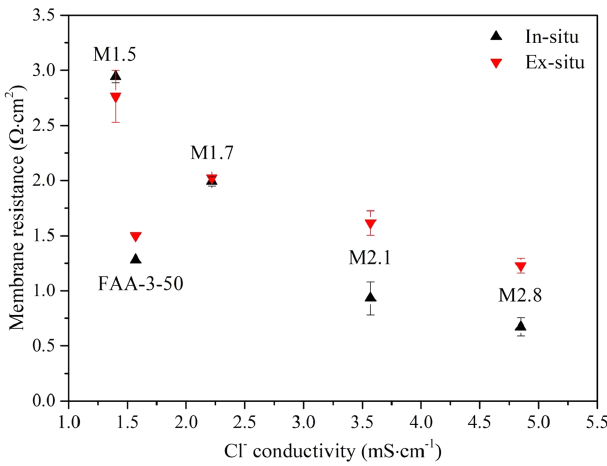
Figure 5. Membrane resistances compared to their chloride ion conductivity.